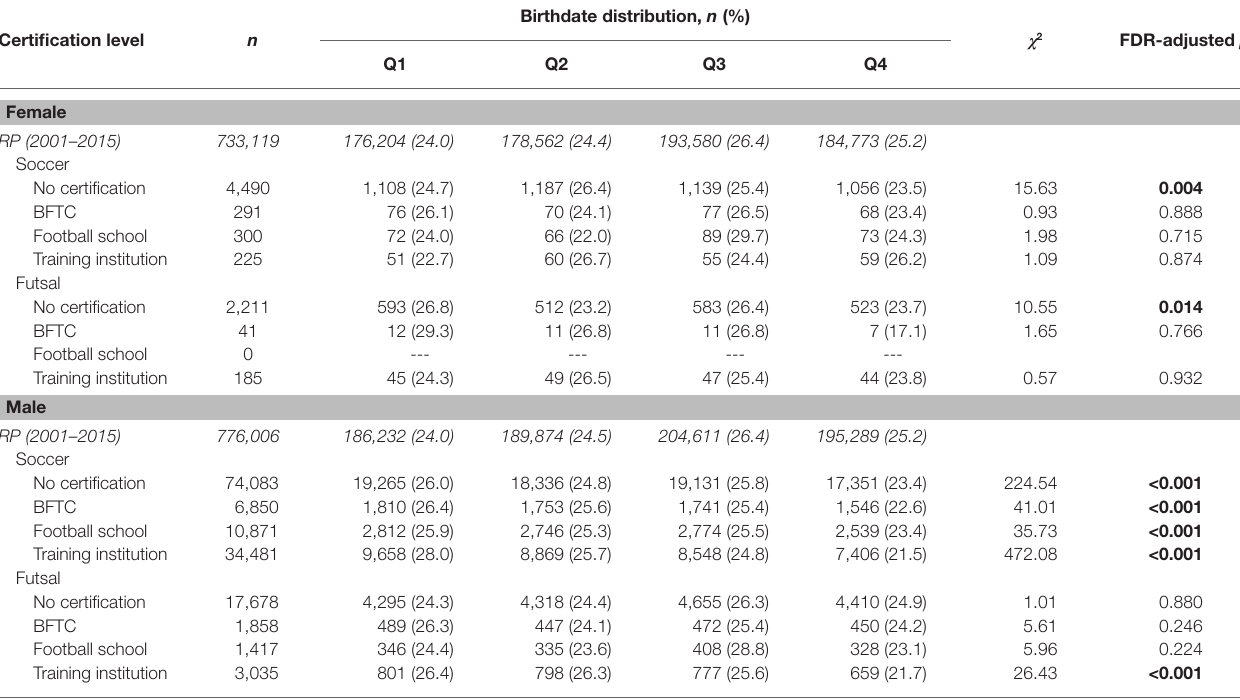
TABLE 3 | Birthdate distribution for female and male youth soccer and futsal players in Portugal according to the different certification levels of clubs and academies, as classified by the Portuguese Football Association.